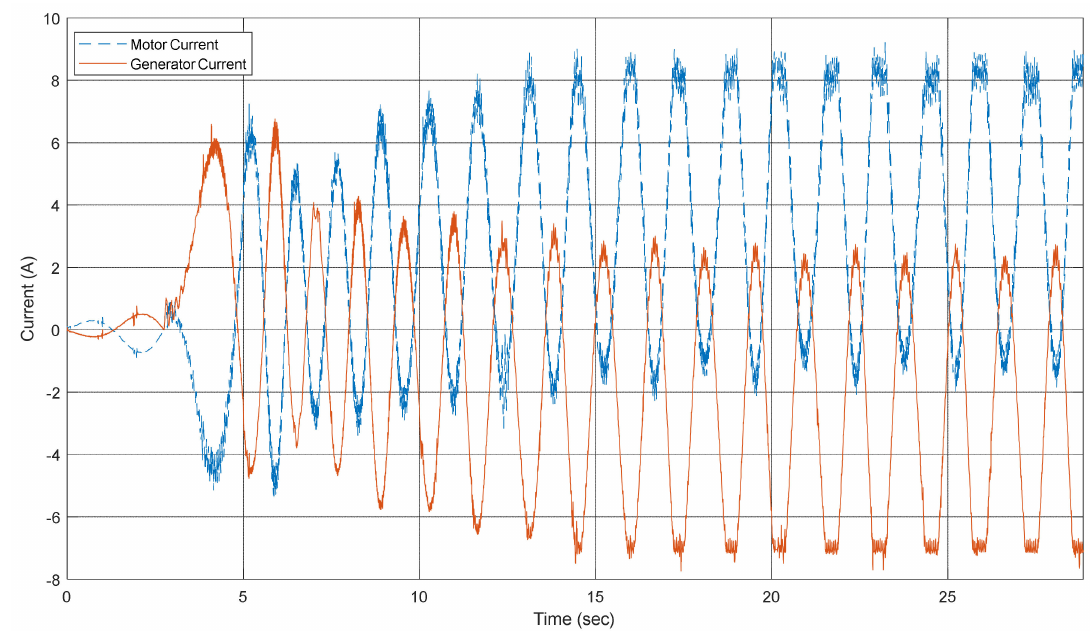
Figure 9. Motor and generator currents for the regular wave case presented in Figure 7a, except crank radius is 1.5 m.